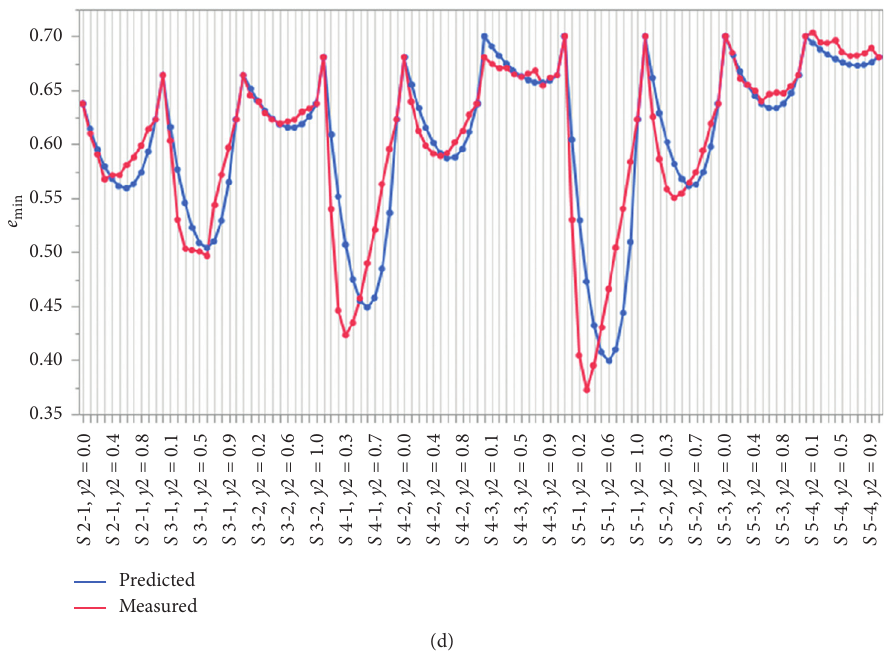
Figure 18: Comparison between the predicted and measured e